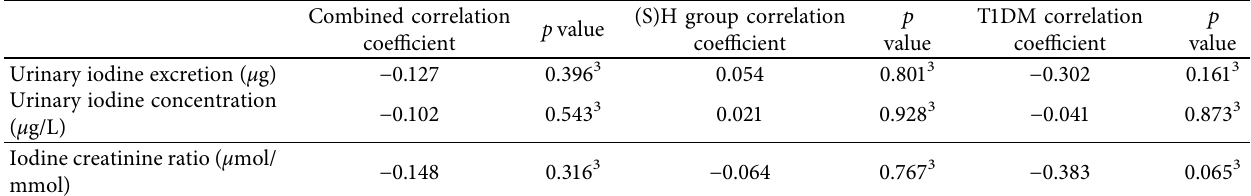
Table 3: Correlation between TSH value and urine iodine excretion.